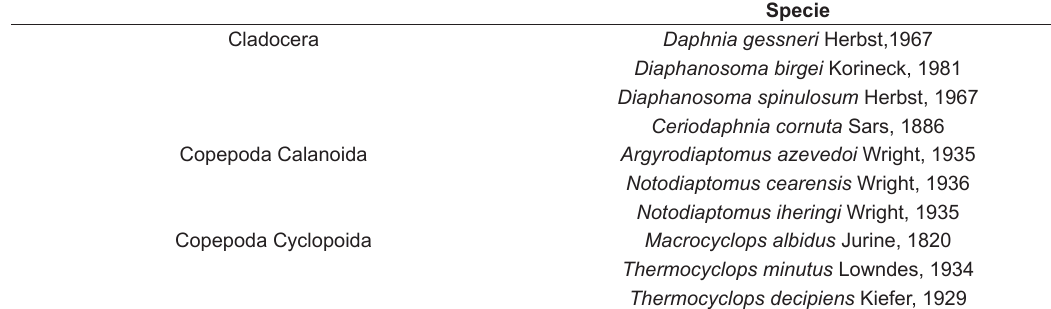
Table 3. List of species of cladocerans and copepods occurring in the period between July 2013 and November 2014 of the reservoir Barragem da Pedra, Jequié, Bahia.